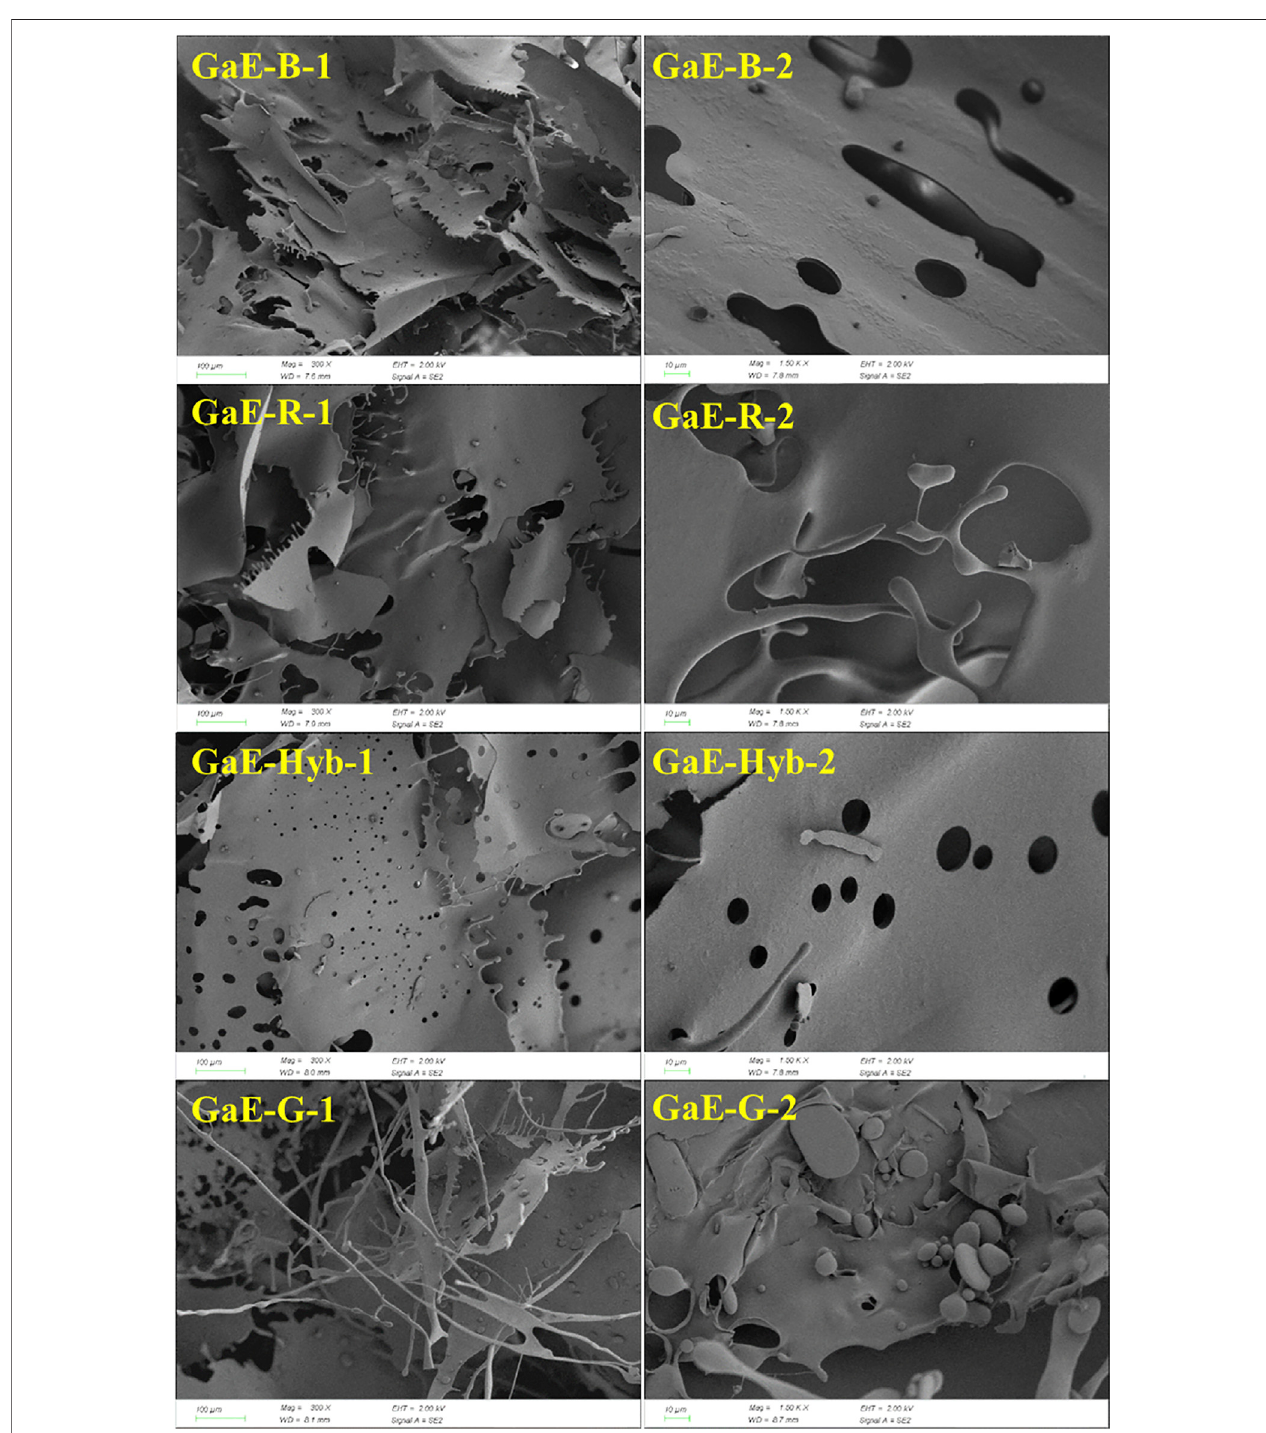
FIGURE 6 | SEM photographs of polysaccharides obtained from different varieties of Gastrodia elata (1 for 300× and 2 for 1500×).